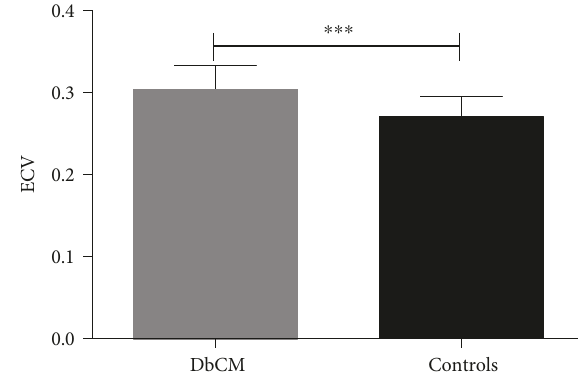
Figure 2: Di ff erences in left-ventricular ECV between patients with DbCM and control subjects. ∗∗∗ means p < 0 001